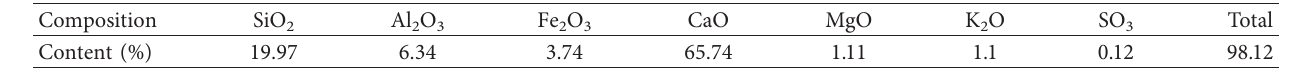
Table 3: Chemical composition of P.S 32.5 cement.